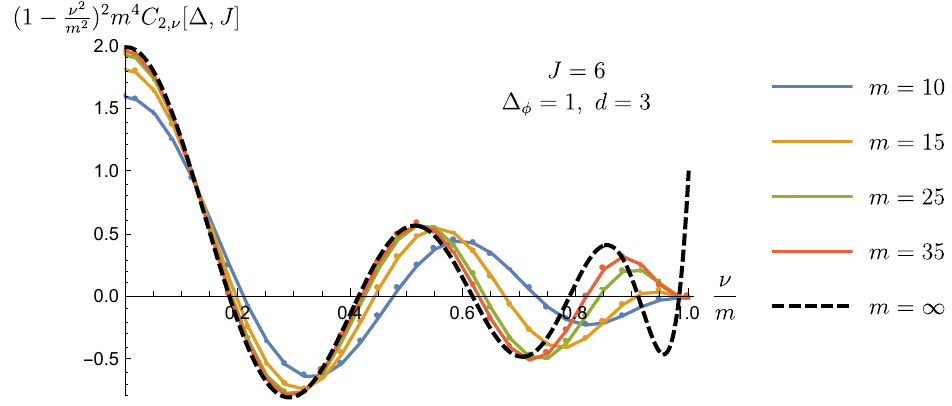
Figure 12. Convergence of functional action in the bulk-point limit: m → ∞ with J and ν/m fixed. The dots, connected to guide the eye, show the exact action computed using the Mellin representation; the dashed line shows the saddle-point result from (3.38). The slower convergence near ν = 1 is compatible with the observed collision of saddle m